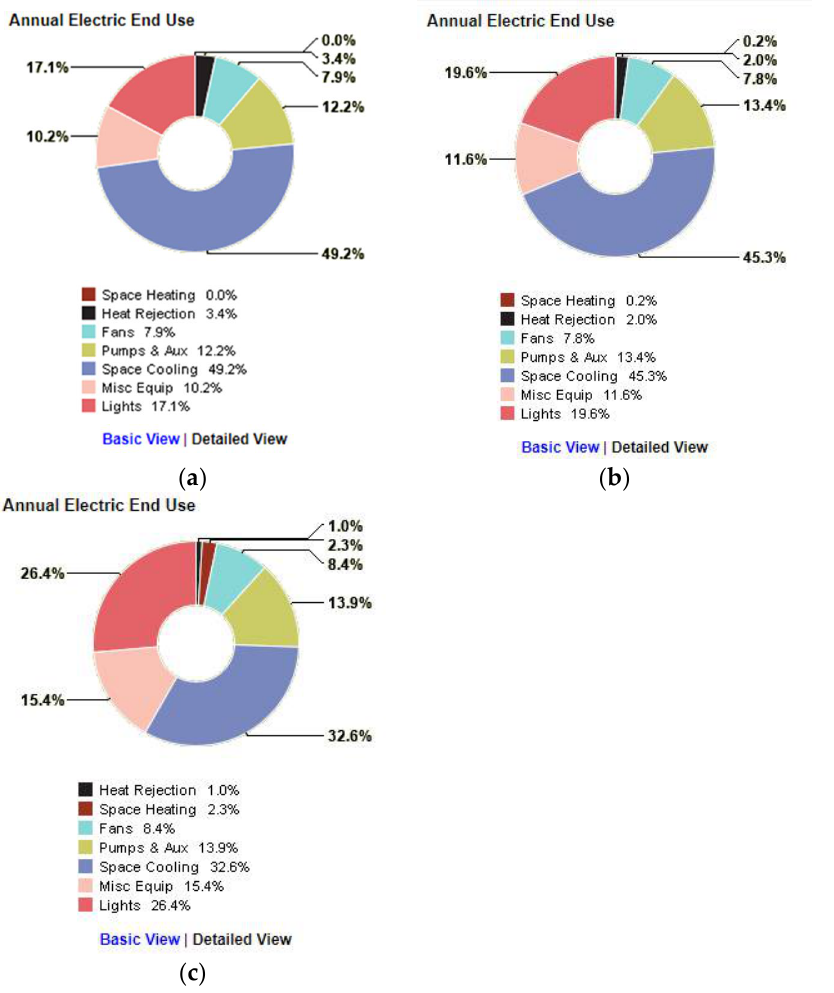
Figure 9. Annual electric end use charts obtained by Green Building Studio. ( a ) Punta Cana; ( b ) Armação dos Búzios; ( c ) Capri.